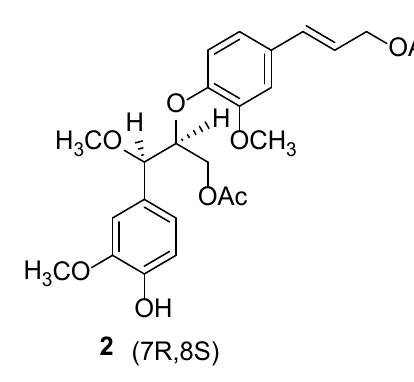
Figure 1. Structures of compounds 1, 2.